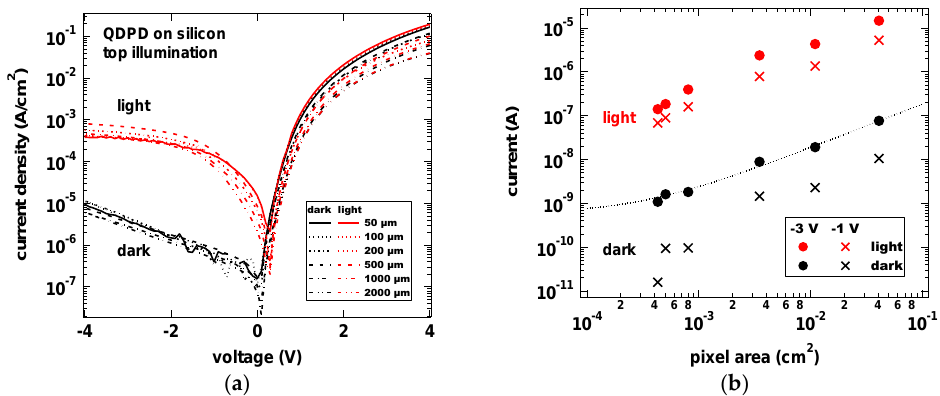
Figure 9. Dark and photocurrent density vs. voltage curves ( a ); and current vs. pixel area curves ( b ) for active areas between 50 × 50 μm 2 and 2 × 2 mm 2 .